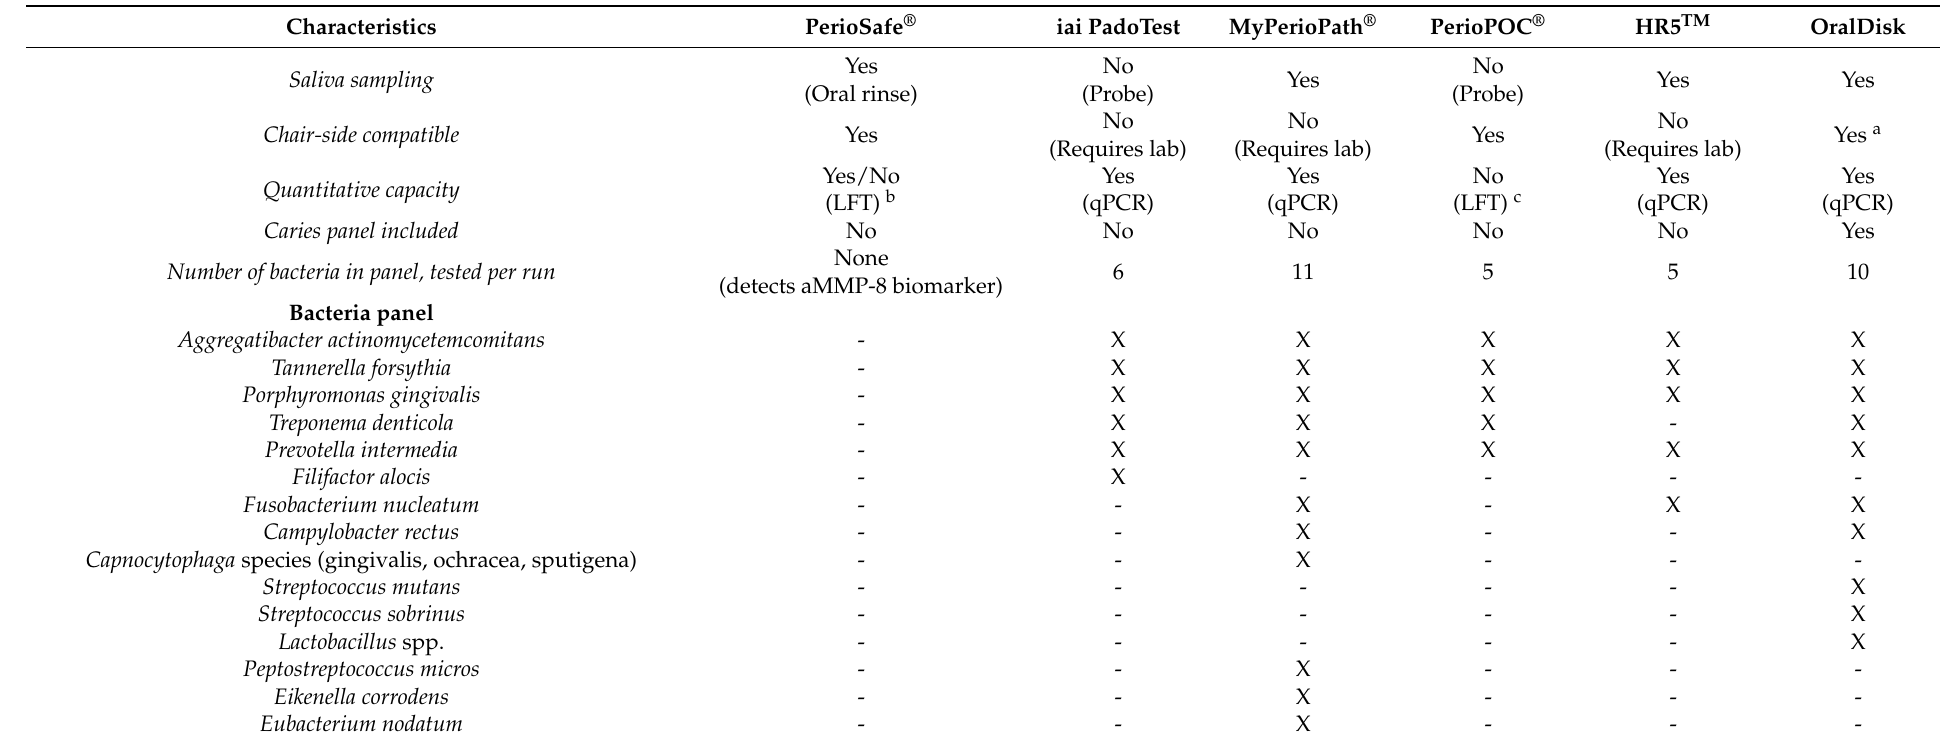
Table 4. List of basic performance characteristics for a range of molecular-based methods of oral health assessment. ‘LFT’ stands for ‘Lateral Flow Test’. Bacteria that are not included in the panels of some technologies are marked with